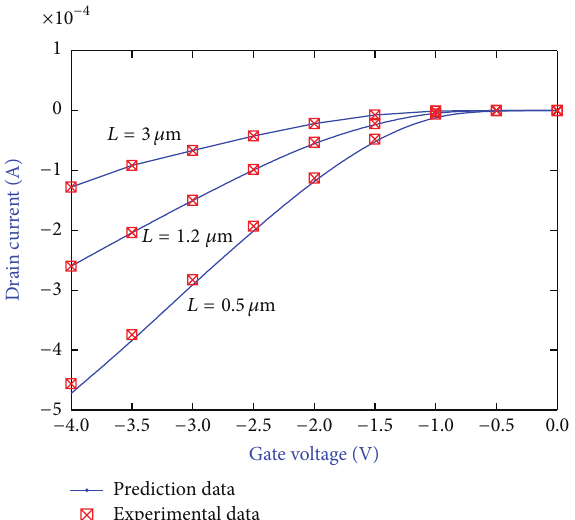
Figure 9: Comparison of 𝐼 𝑑 measured results and prediction data of the group 1B diagnostic samples (as 𝐿 = 0.5 , 1.2, 3- 𝜇 m; 𝑉 𝑑 = −3 V).